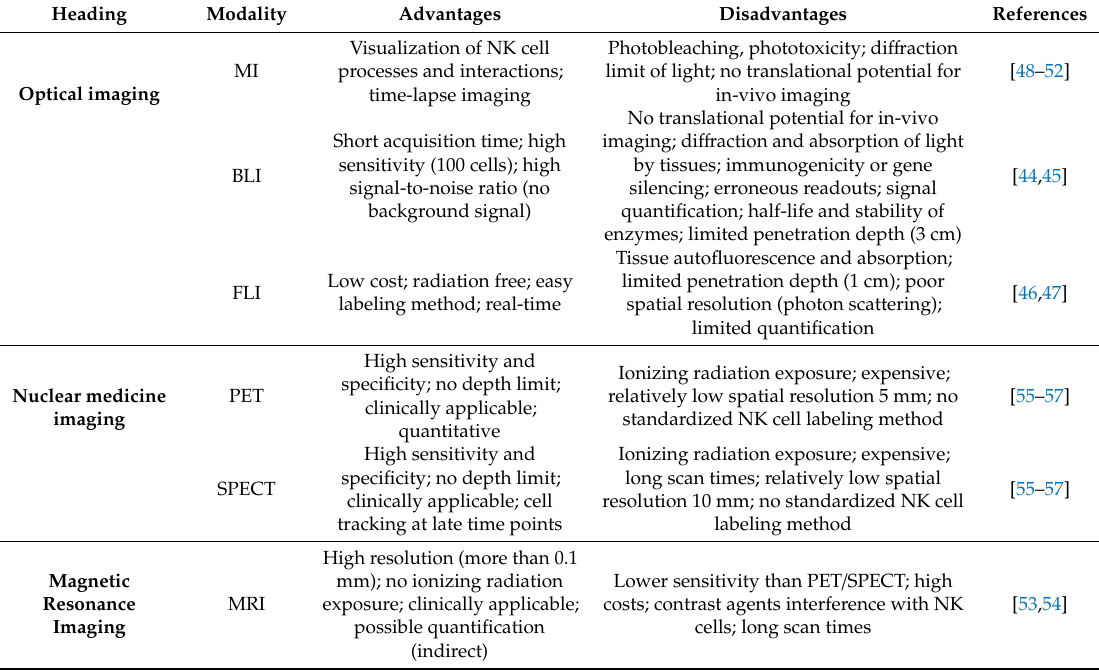
Table 1. Advantages and disadvantages of di ff erent imaging